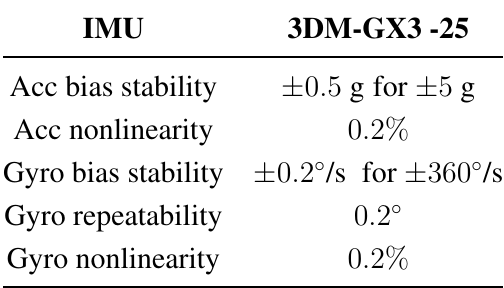
Table 1. 3DM-GX3-25 IMU characteristics. Acc,